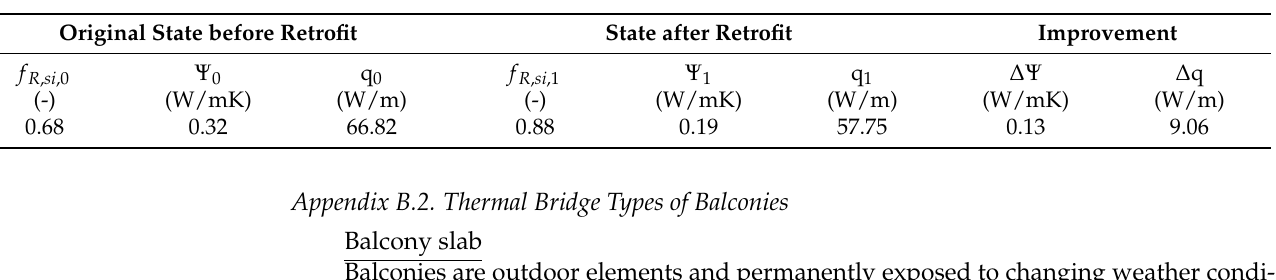
Table A11. Quantifiable results of the thermal bridge retrofit of a connection between wall and rooftop (ThermCad thermal bridge simulation calculation).